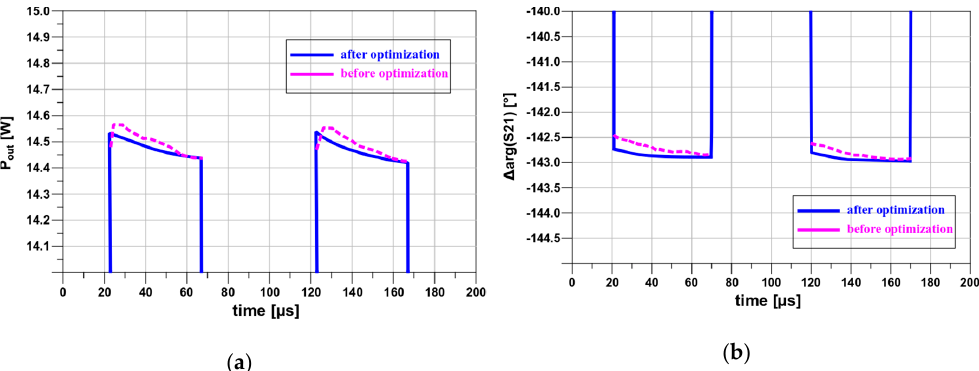
Figure 13. Transmittance changes of the amplifier after and before optimization: ( a ) amplitude changes and ( b ) phase changes during pulse for carrier frequency f = 1.05 GHz. Transmittance variations before and after optimization with obtained output power and PAE of the test amplifier are presented in Table 3. Table 3. Transmittance changes before and after optimization.